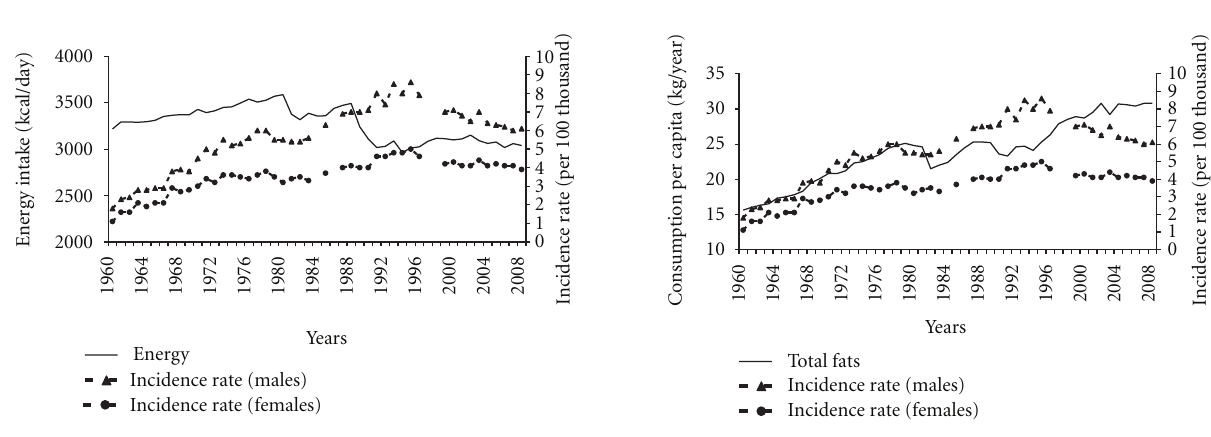
Figure 1: Energy intake and pancreatic cancer morbidity 1960– 2008.